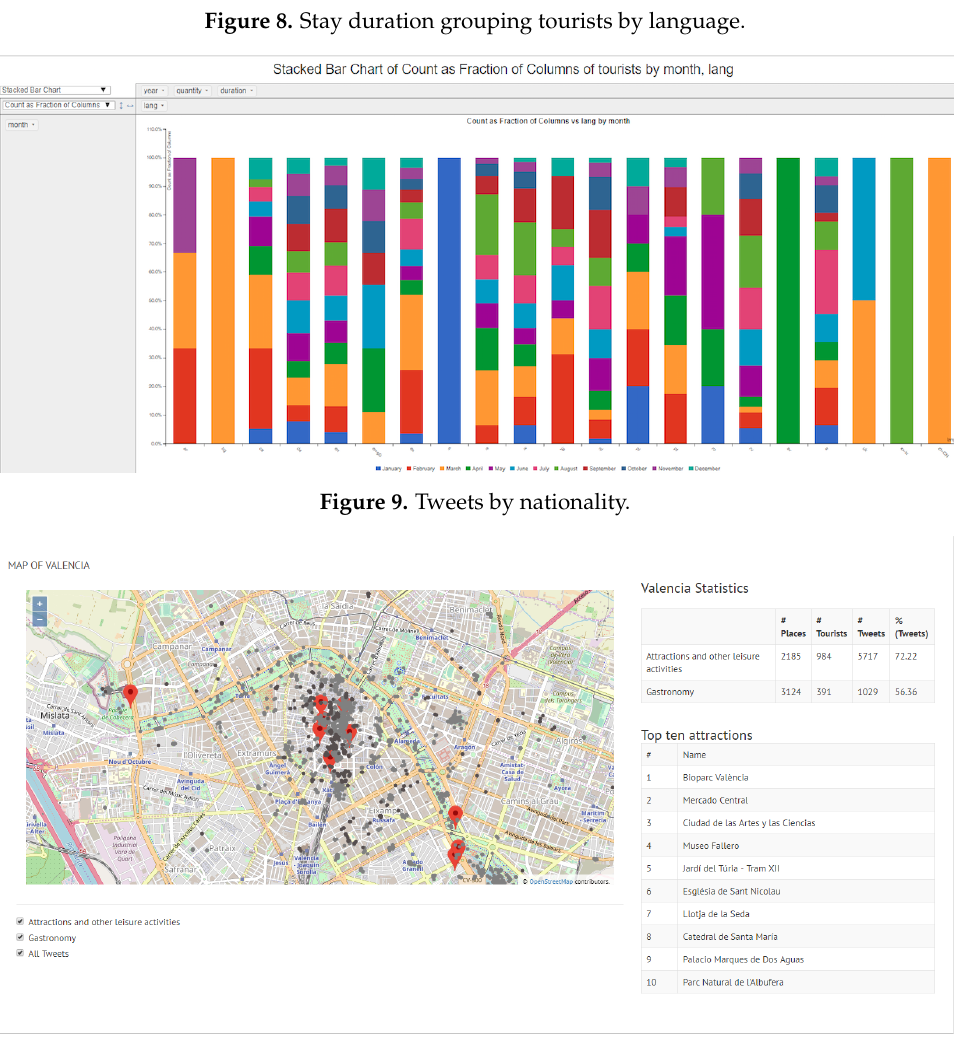
Figure 10. Distribution of tweets around ten attractions in